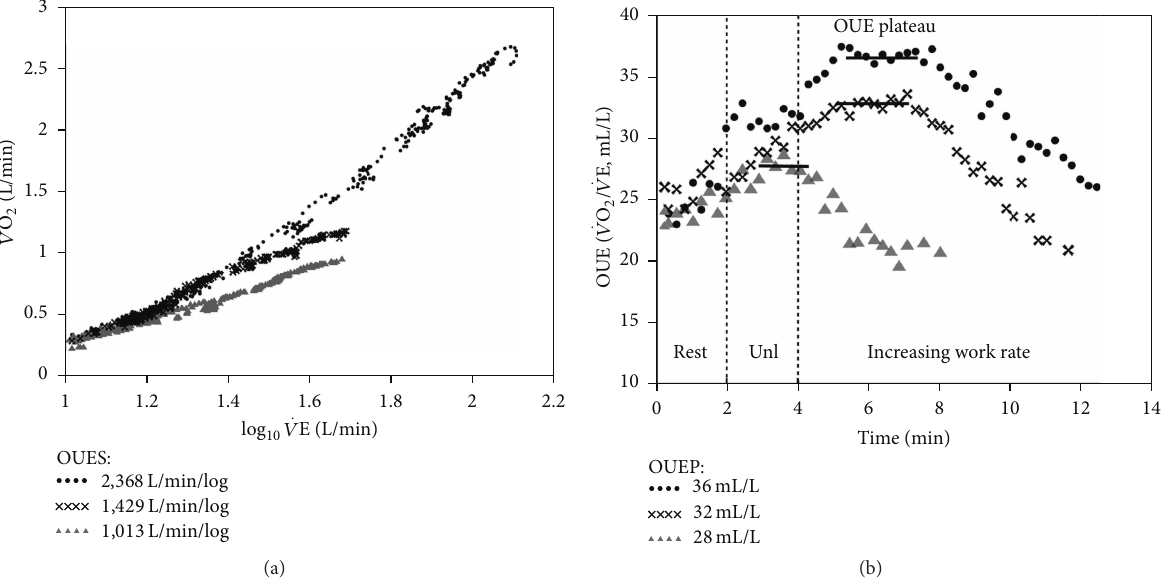
̇𝑉 ) and minute ventilation ( ̇𝑉 ) during incremental exercise in a healthy subject (∙∙∙∙) and O 2 E ̇𝑉 ̇𝑉 upon log 10 is the oxygen uptake efficiency slope (OUES) which O 2 E ̇𝑉 ̇𝑉 ̇𝑉 ̇𝑉 / ̇𝑉 for a 10-fold rise in . (b) The highest ratio is the efficiency slope (OUEP) which is the average O 2 E O 2 E O 2